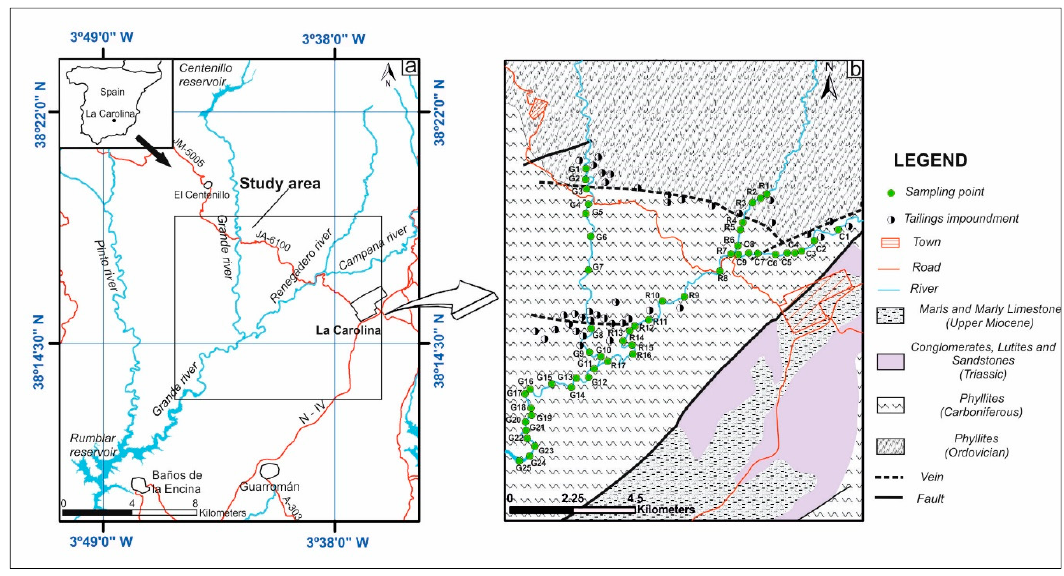
Figure 1. ( a ) General situation of the study area. ( b ) Spatial distribution of the sampling points and location of tailings impoundments.